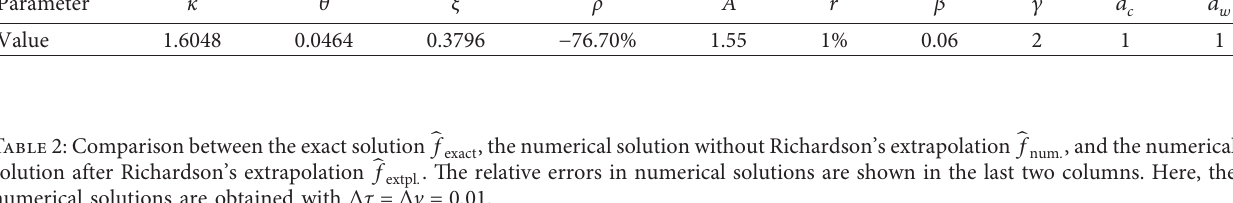
Table 1: Values for the parameters κ , θ , ξ , ρ ,A, r, β , c ,a